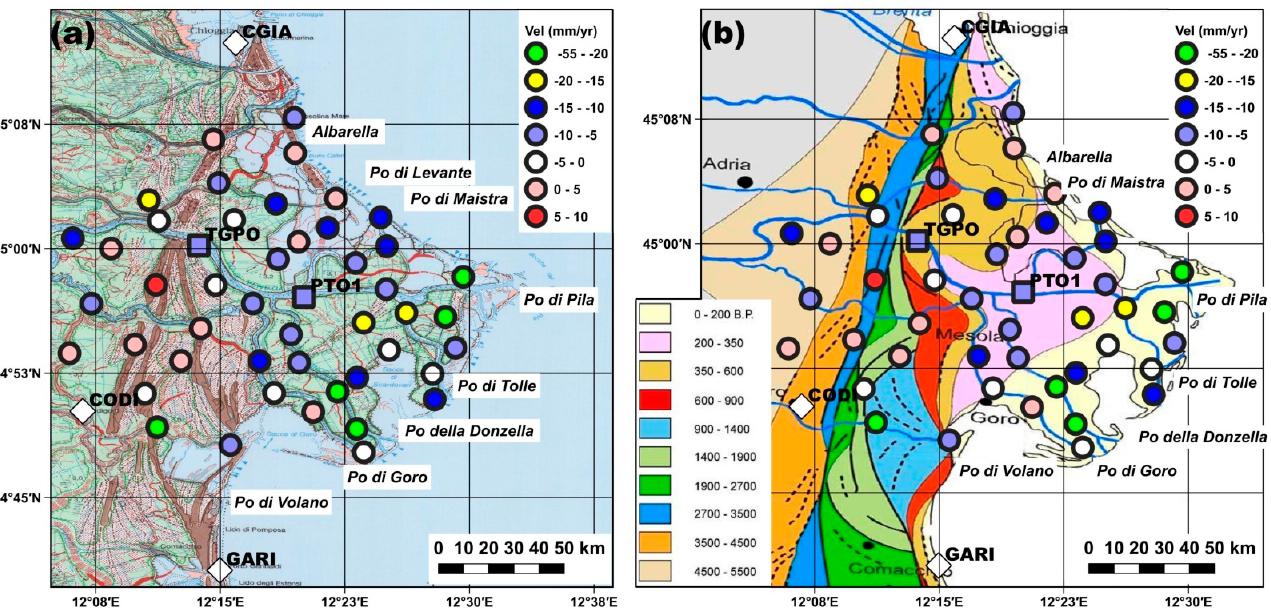
Figure 4. Vertical velocity field obtained analyzing the observations acquired during the two PODELNET surveys. Diamonds and squares show the position of the three CGNSS stations chosen as reference and benchmark sites, respectively. The background image is the geomorphological map shown in Figure 1 ( a ) and the Po Delta lobe generations map (( b ), modified from Figure 13 in [72]); are also shown the positions of the seven Po River terminal branches.